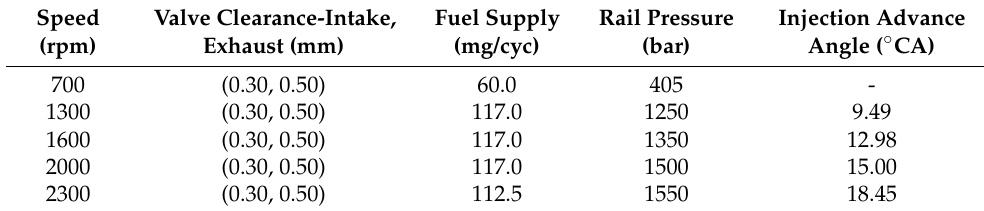
Table 3. Normal working conditions under different speeds.